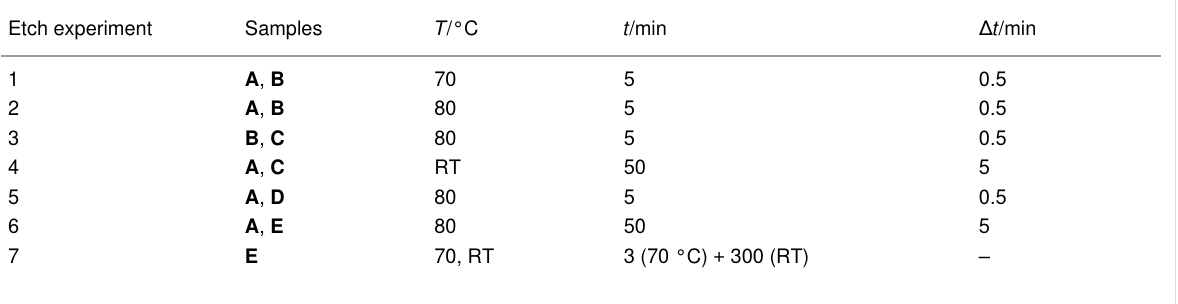
Table 1: Etch experiments conducted to determine GaN etch reaction kinetics. GaN chips were immersed in 30 wt % KOH solution for a total time t . After Δ t , samples were drawn for ICP-OES